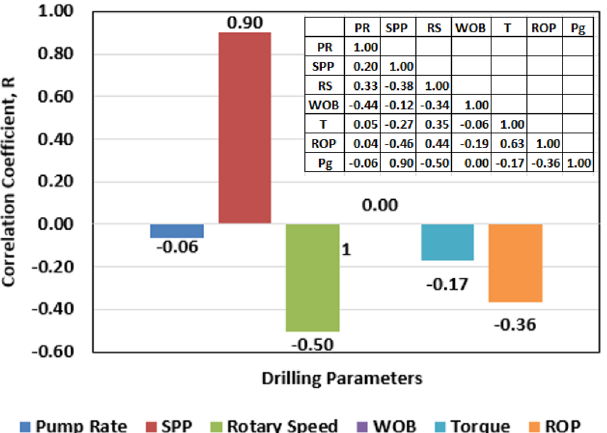
Figure 2. R-values between each input and the formation pressure gradient along with a table containing the R-values between each two variables.